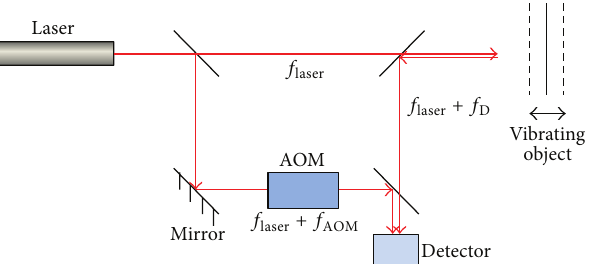
Figure 10: Schematic layout of the heterodyne laser Doppler